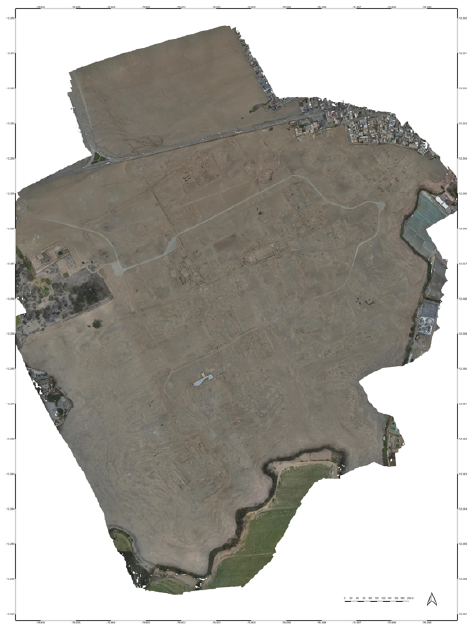
Figure 8 . Orthophoto of monumental part and un small part of north aera